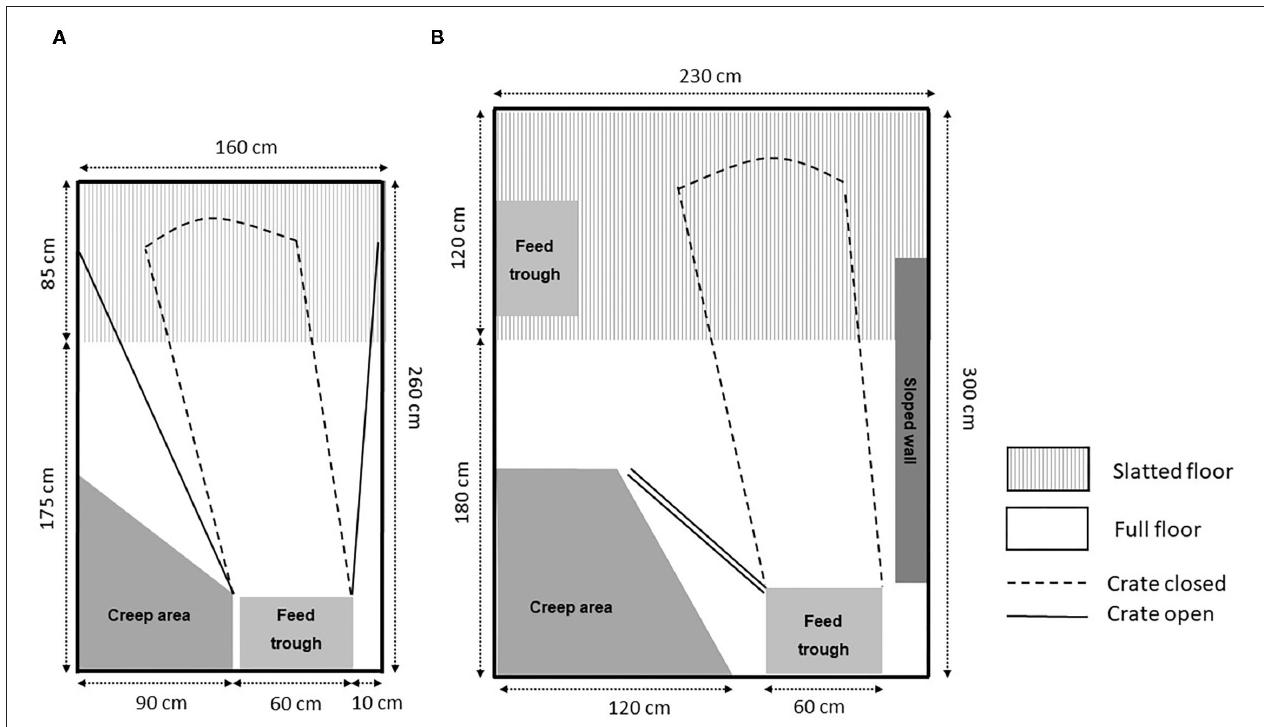
FIGURE 1 | Examples of pens with temporary crating: (A) swing-side crate and (B) SWAP pen. time window for piglet survival and how the pen could function when she is